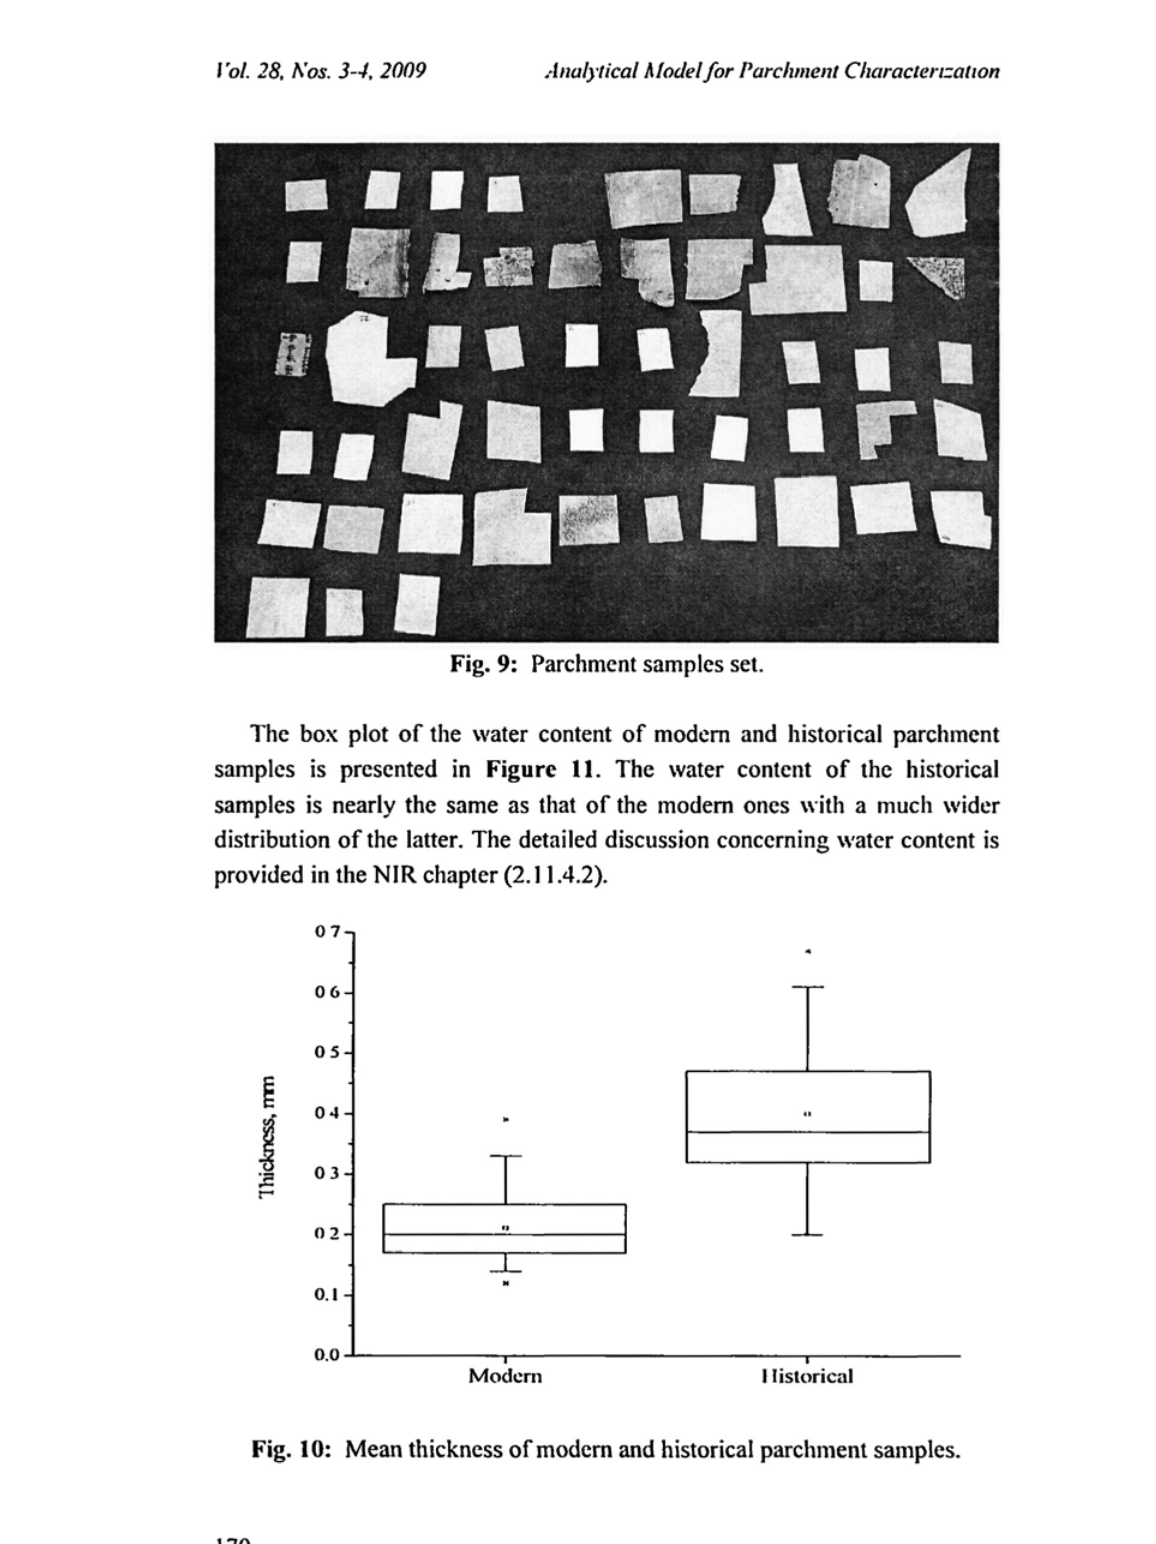
Fig. 10: Mean thickness of modern and historical parchment